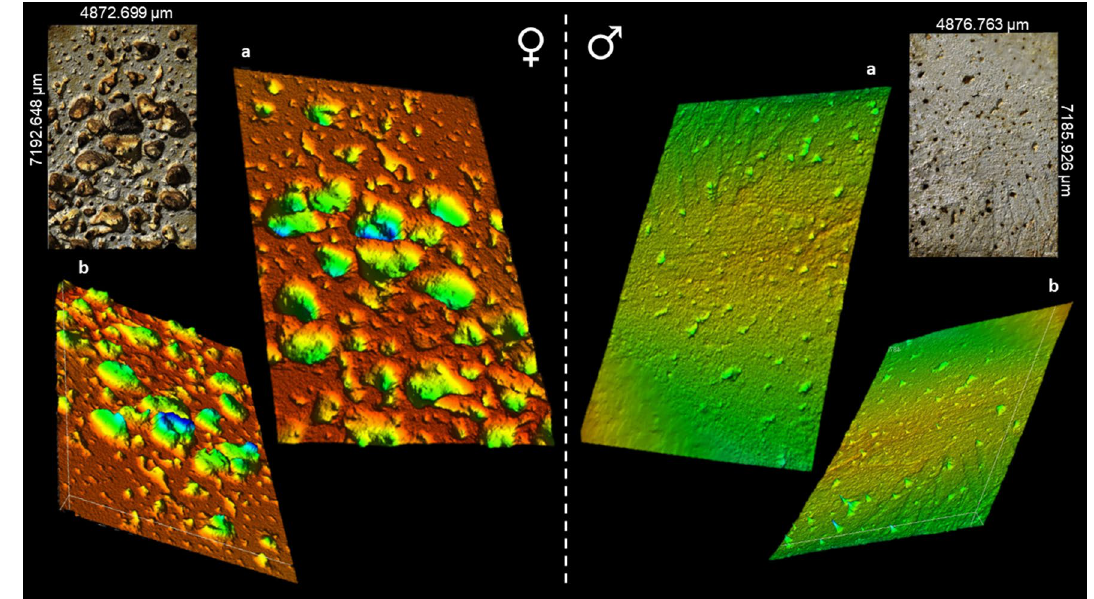
Figure 3. Intra-cortical surfaces scanned using a three-dimensional laser confocal topography microscope Olympus OLS5000 with applied false-coloured heat map to illustrate extreme differences in porosity in archaeological posterior midshaft femur samples from Talasiu individuals estimated as female ( ♀ , ID: Sk3.1) and male ( ♂ , ID: Sk3.2). ( a ) shows topography viewed superiorly from the bone surface, whereas ( b ) is reverted upside down to show the inferior view of the same scan as ( a ).